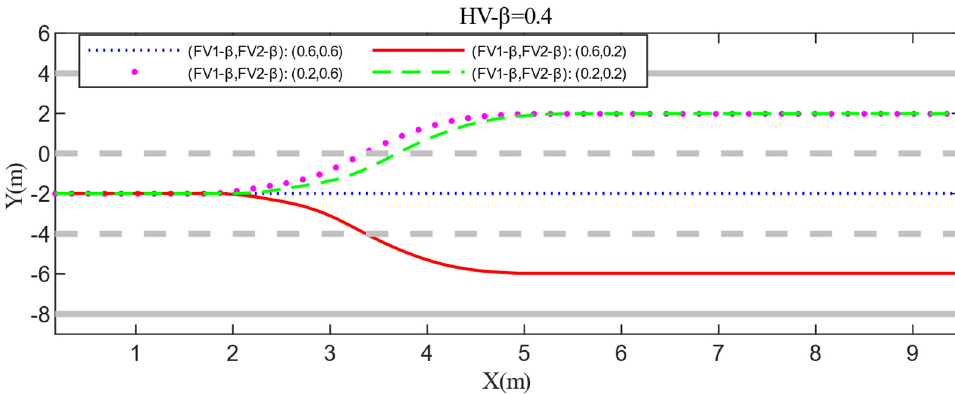
Figure 13. Test results for decision-making and path planning in Scenario B.